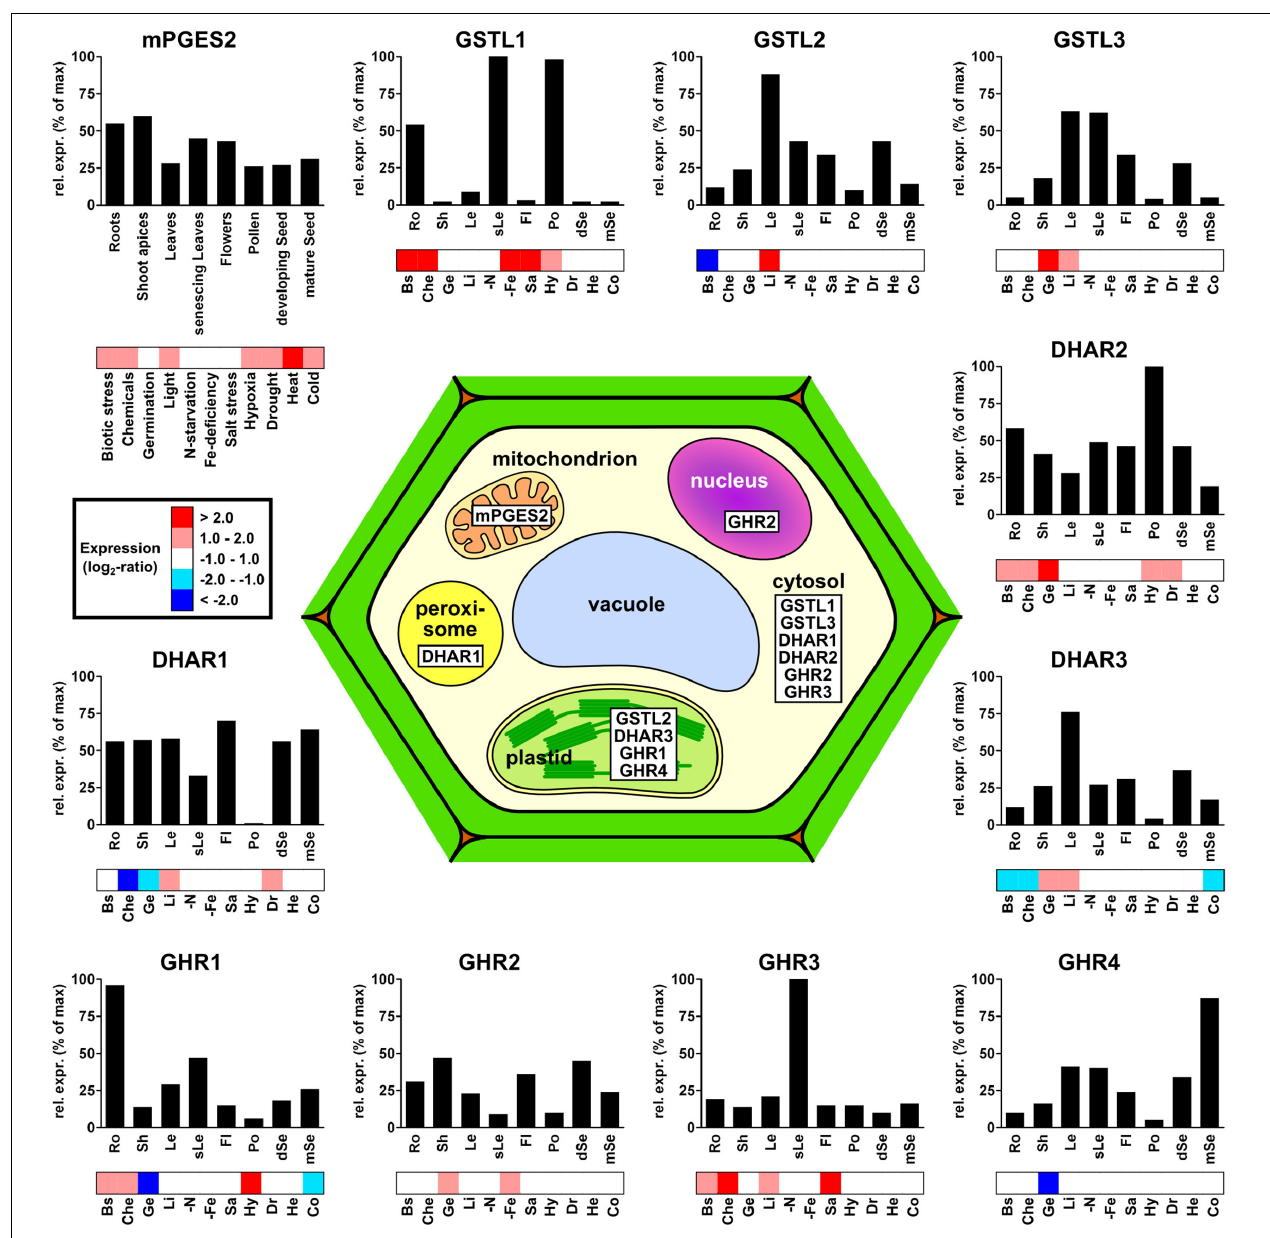
FIGURE 4 | Subcellular localization and gene expression profiles of the different Arabidopsis thaliana Cys-GSTs. For each GST, the relative transcript expression is shown in relation to both plant developmental stages (bar-graphs) and perturbations (heatmaps). For clarity, the number of developmental conditions was reduced to eight classes, where each gene was normalized to its maximum expression within the selected dataset (see